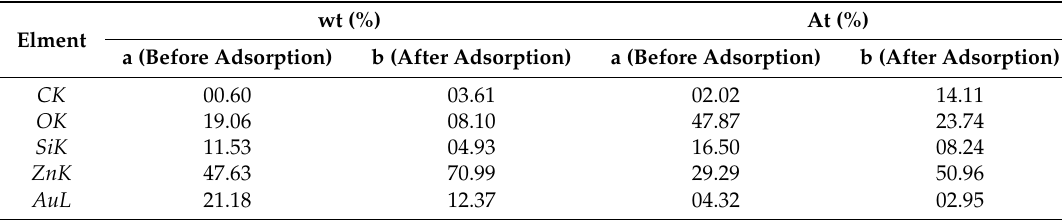
Table 2. EDS analysis of selected particles of hemimorphite in a and b.